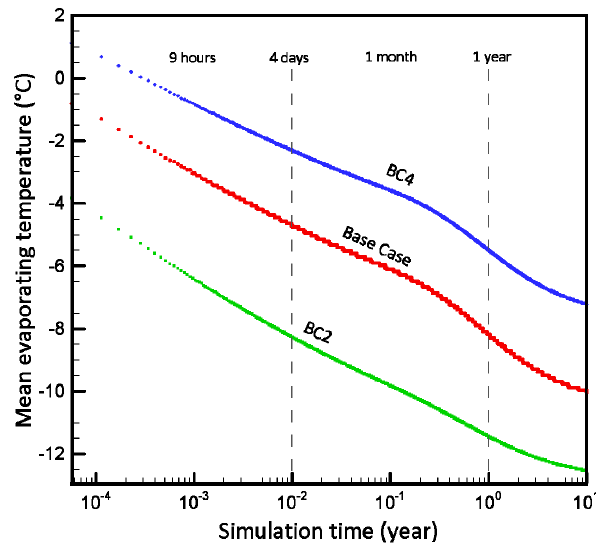
Figure 5. Mean evaporating temperature.